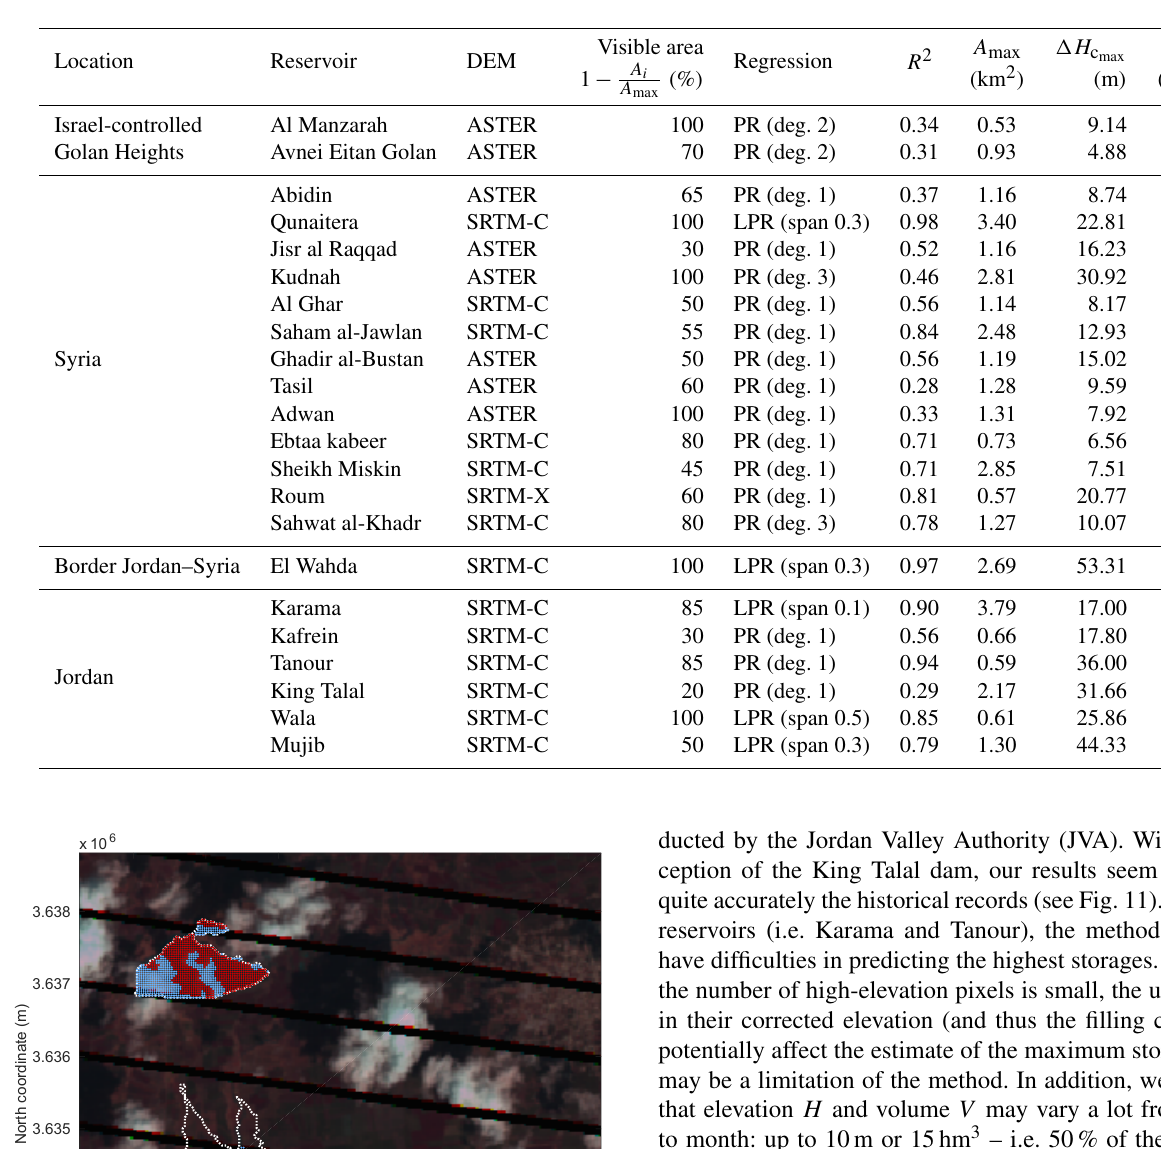
Table 1. Parameters and results of the elevation–area regression. PR and LPR stand for polynomial regression and local polynomial regression respectively. R 2 is the coefficient of determination between the corrected elevation H c and the elevation H for pixels taken into account by the regression (red dots in Fig. 8).